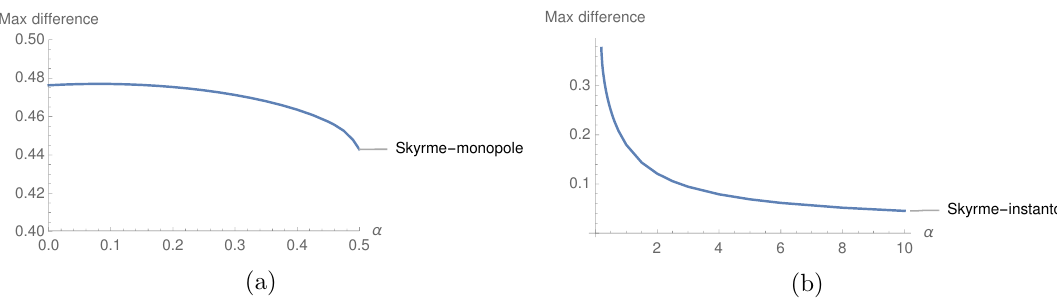
Figure 11. The maximum di(cid:11)erence between the Skyrme-monopole/Skyrme-instanton Skyrme (cid:12)elds, and the ordinary Skyrme (cid:12)eld, as a function of (cid:11)